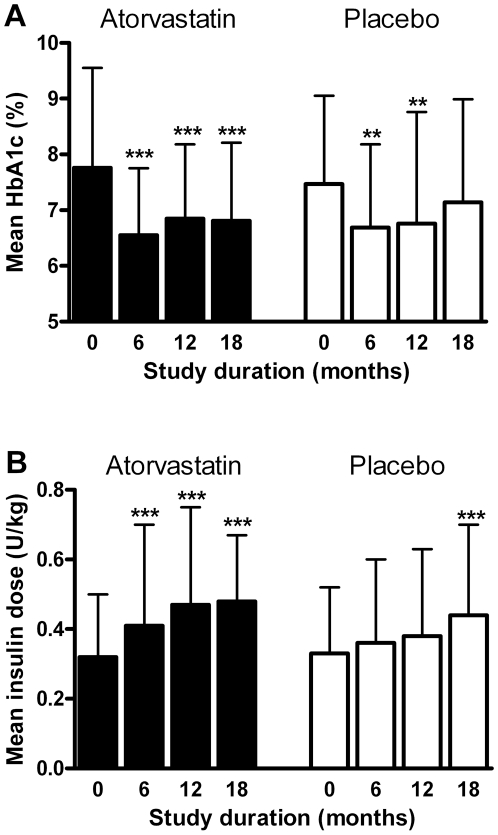
Metabolic control during the study (HbA1c (a), insulin dose
(b).Filled bars, atorvastatin, empty bars, placebo. Bars indicate standard
deviation, for HbA1c p-values describe differences of mean values from
baseline determined by ANCOVA with correction for baseline HbA1c and BMI
(which correlated with later HbA1c levels), **, p<0.01;
***, p<0.001. Mean insulin doses per kg bodyweight were
different between groups at 12 months (p = 0.007,
comparison of log-transformed mean values by ANCOVA with correction for
baseline insulin dose and age (which correlated with later insulin
doses).